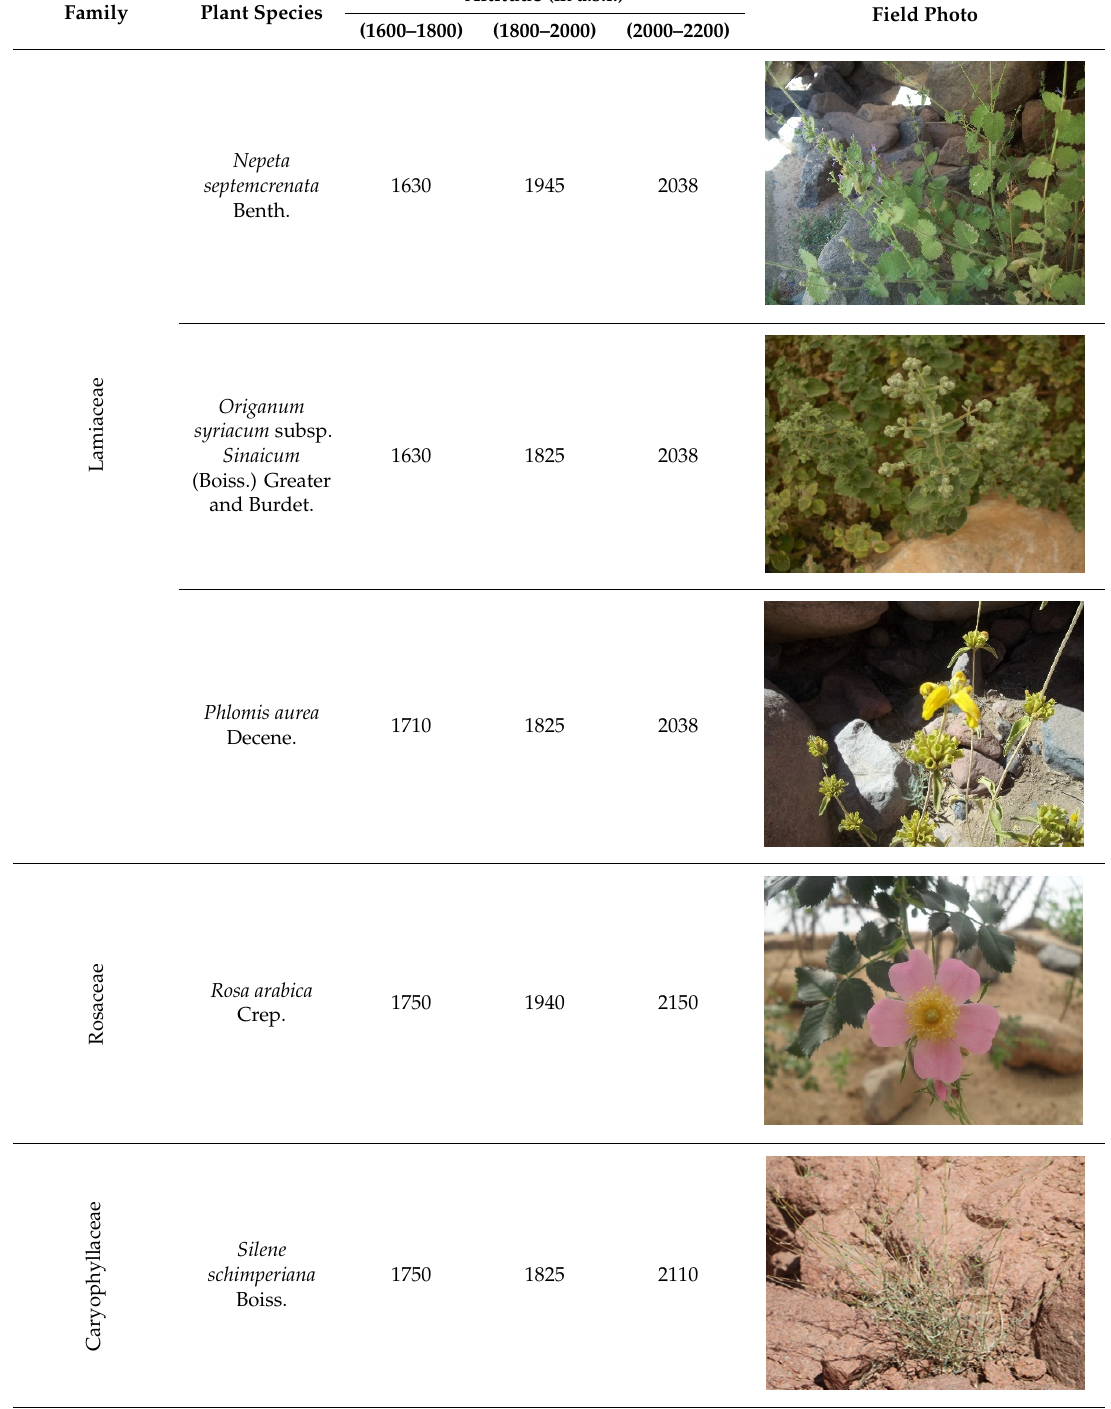
Table 2. Families, scientific names, altitude, and field photos of the studied endemic species. Family Plant